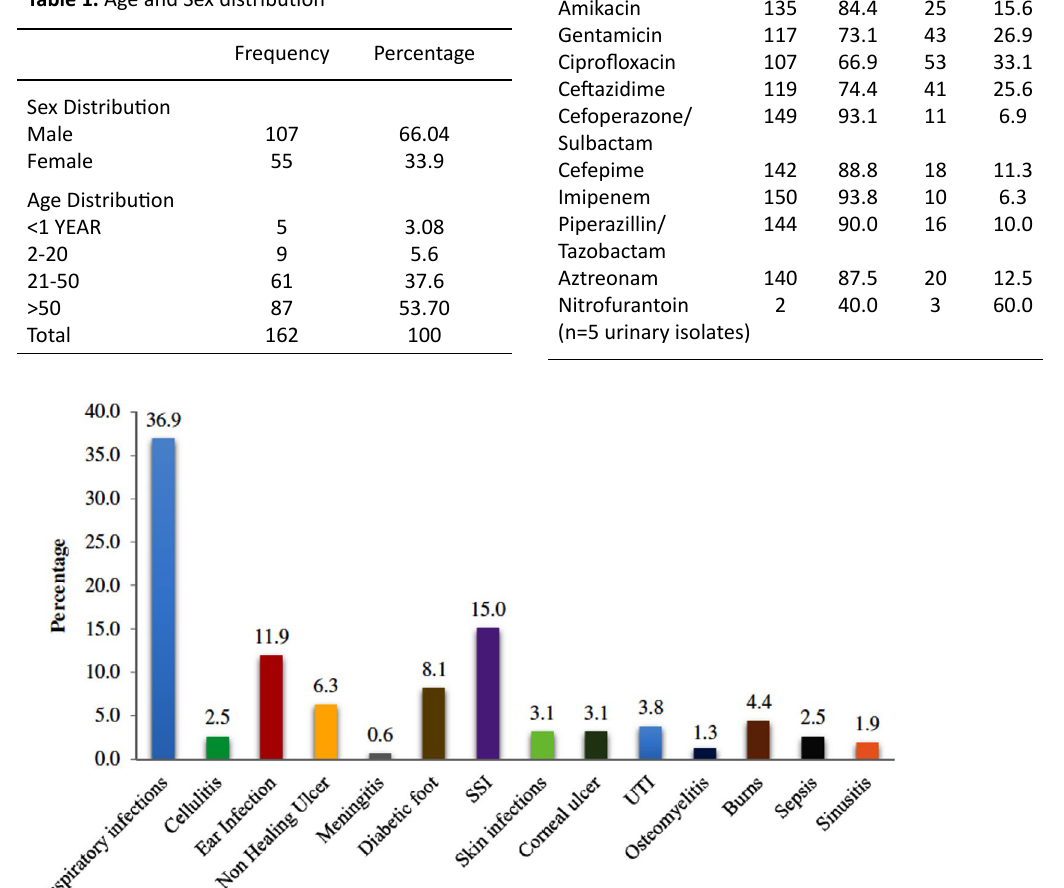
Table 1. Age and Sex distribution